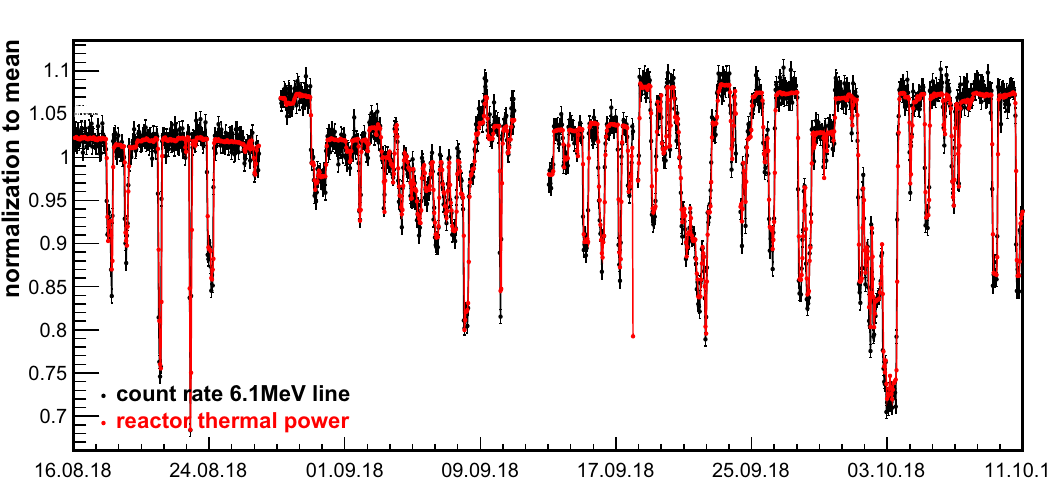
Fig. 23 Correlation of thermal power to the count rate in the 6.1MeV γ -line of 16 N. The curve is interrupted if no thermal power data is available and during the calibration of the